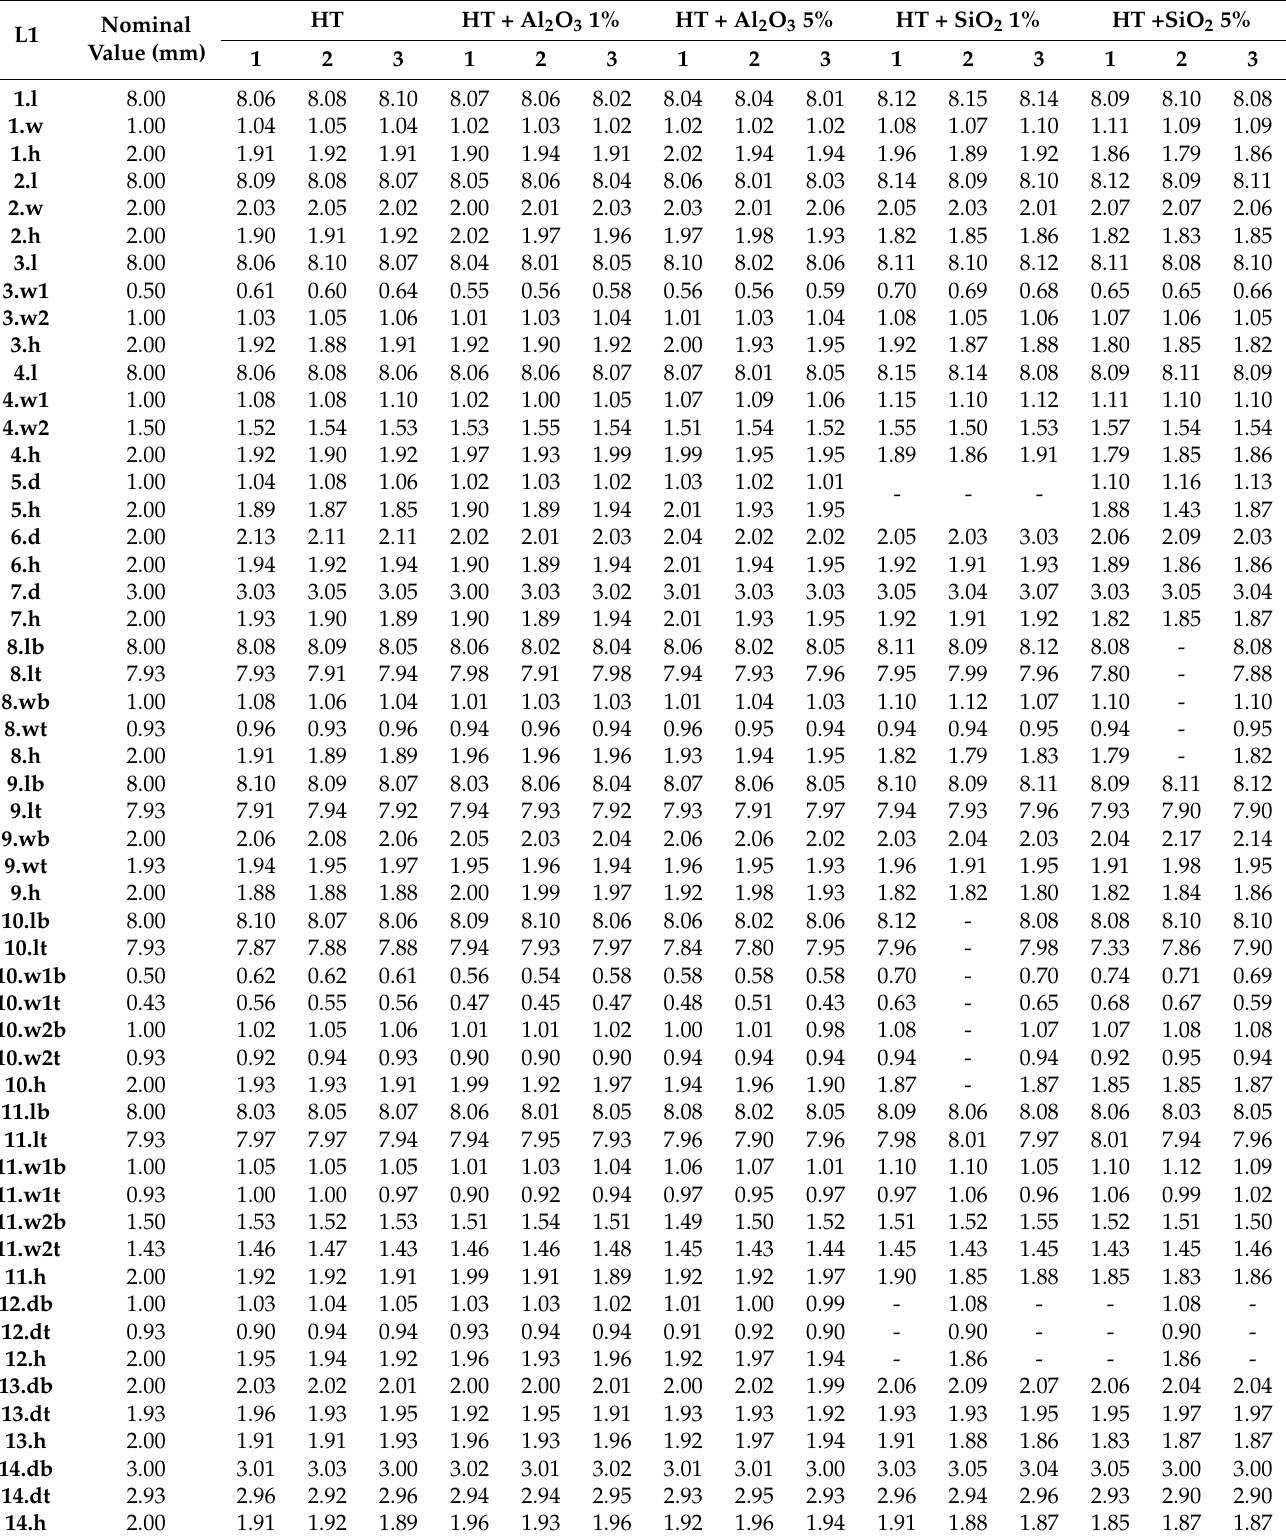
Table A1. Dimensional analysis detailed measurement results (outward